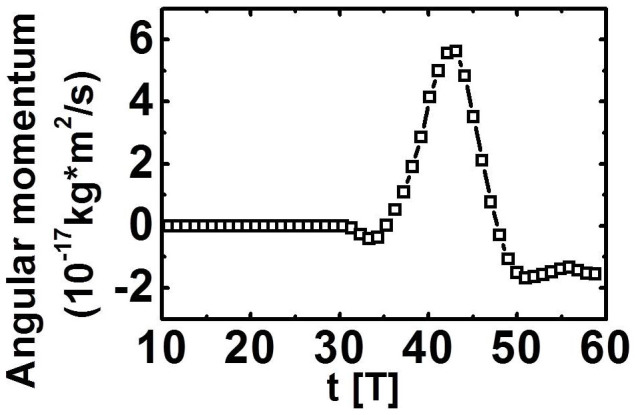
Total angular momentums me (ypz − zpy) + mp (ypz − zpy) in the x direction.